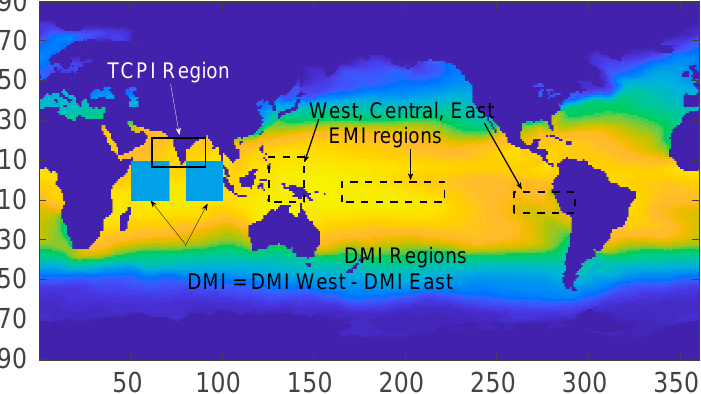
Figure 1. The spatial domains where TCPI, DMI and El Niño Modoki datasets are considered. TCPI is in the North Indian Ocean, DMI regions are south of the TCPI region. The image has SST values over the sea surface and the land is masked in the algorithm. DMI is computed as the difference between the western and the eastern regions, as shown. The El Niño Modoki regions are illustrated with dashed lines.